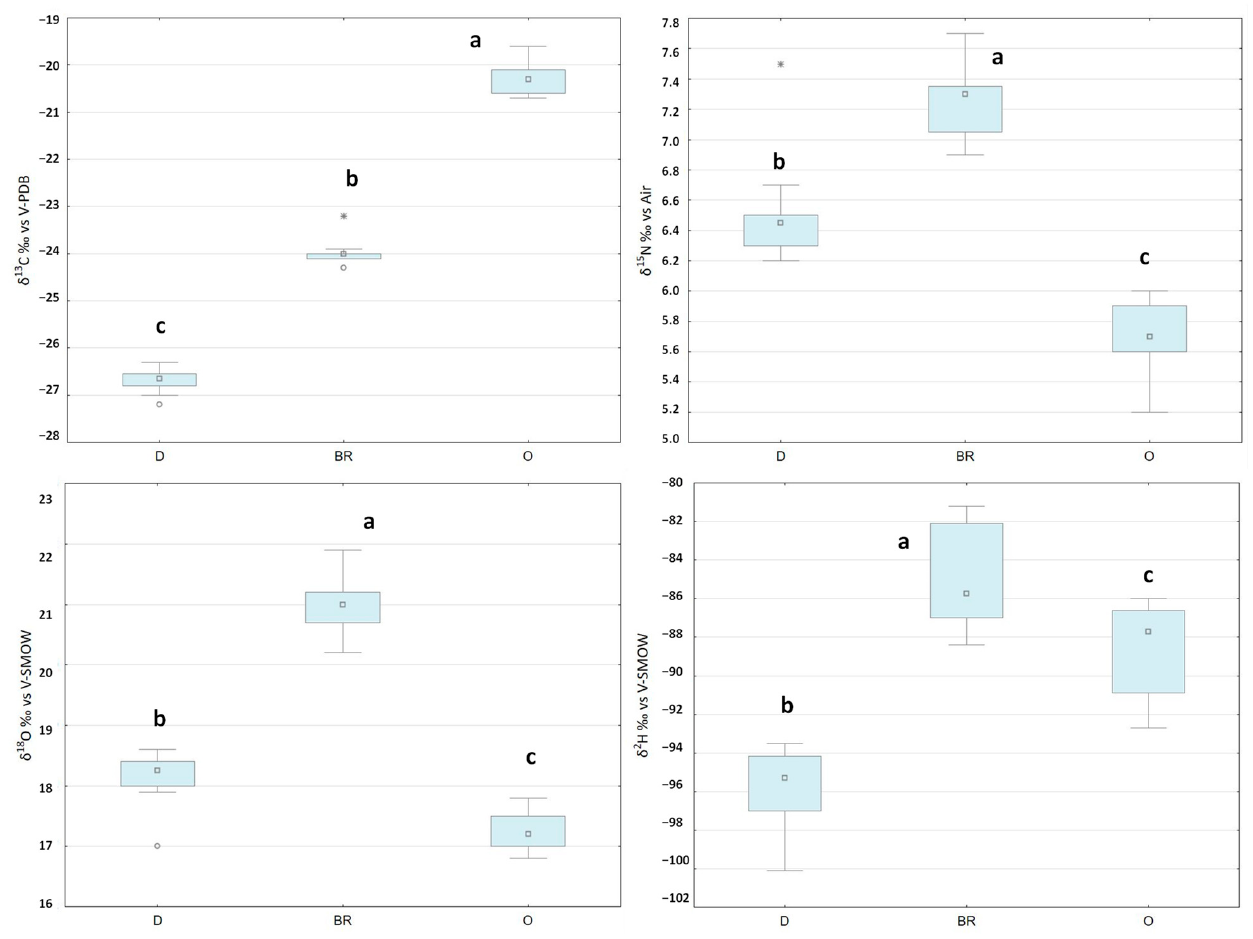
Figure 1. Isotopic value ranges for the three groups: Djebel (D), Bou-Rebiaa (BR), and Oueslatia (O). Statistically different groups ( p < 0.01), according to the ANOVA, are denoted by different letters (a,b,c).